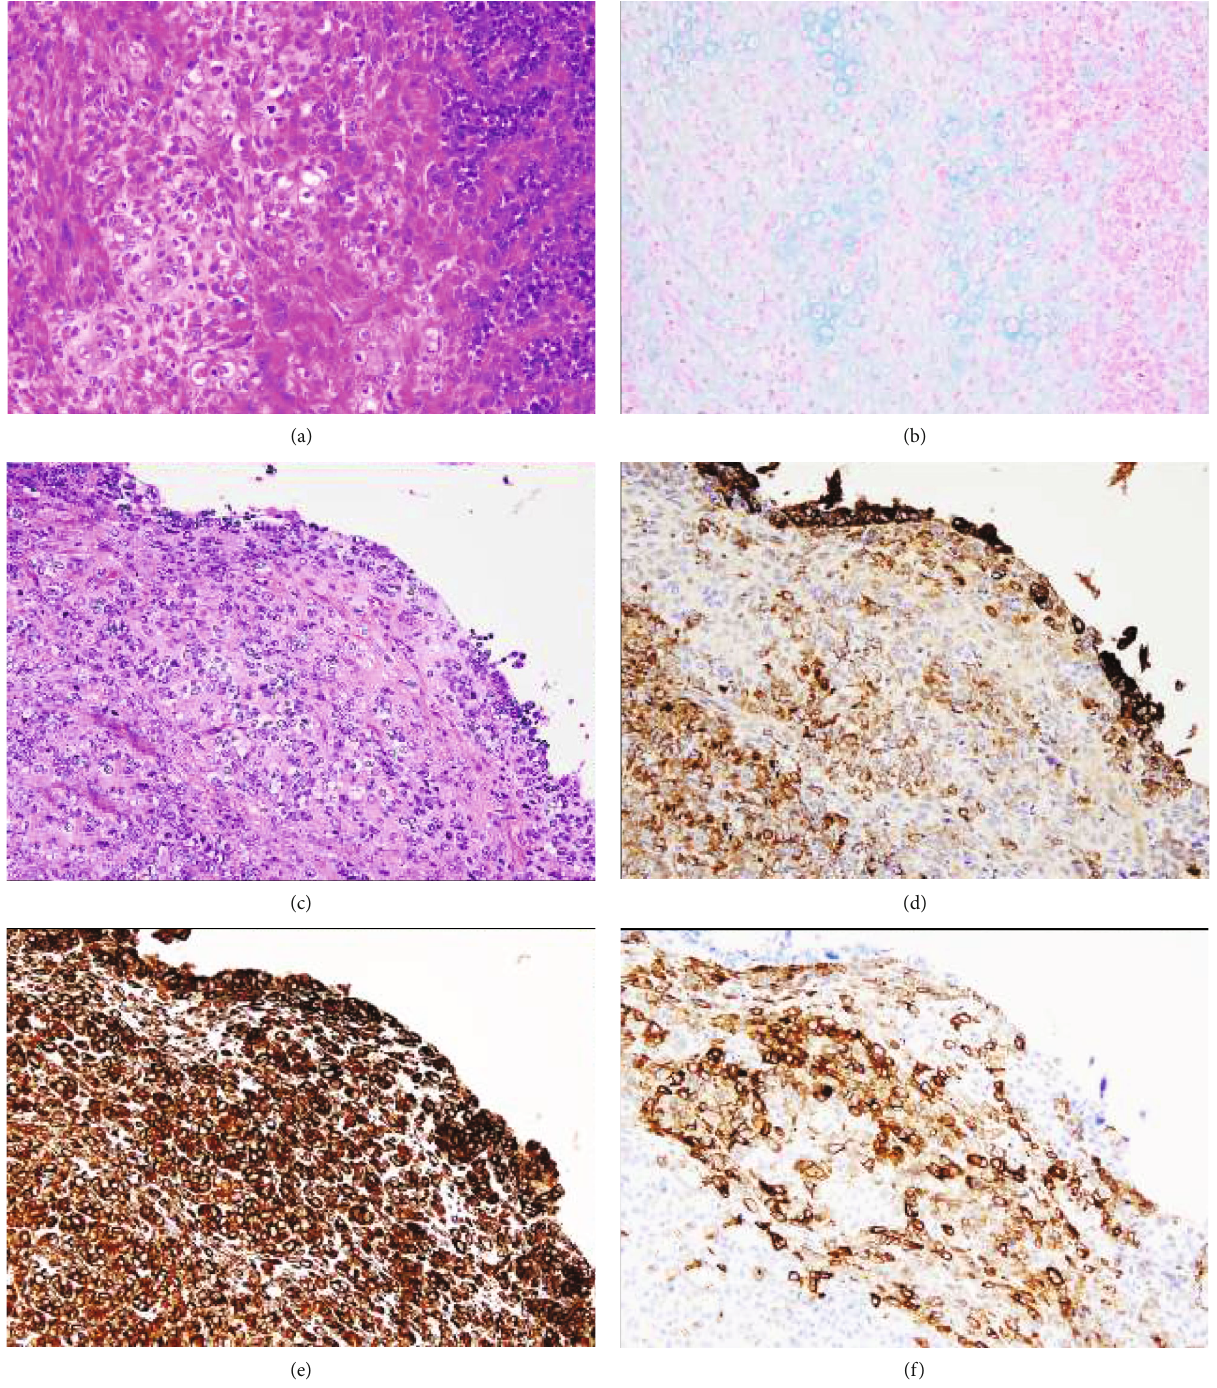
Figure 3: Histology image of the sarcomatous component. (a) Heterologous element with chondroid di ff erentiation. (b) Chondroid stroma showed positive staining with Alcian blue. (c) Proliferation of spindle and polygonal stromal cells. (d) Epithelial cells were stained for AE1/AE3. (e) Vimentin was positive both in epithelial and stromal cells. (f) CD10 was positive in the sarcomatous cells. (A: H&E staining, × 20, B: Alcian blue × 20, Immunostaining C-F: ×